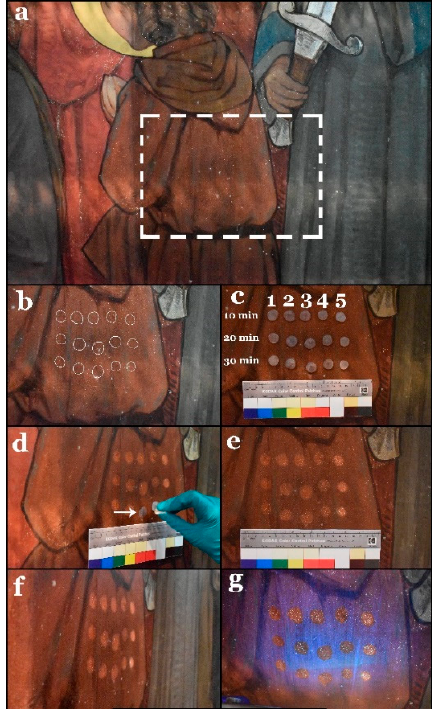
Figure 5. ( a ) General view of the selected area for the first stage tests. ( b ) Selected spots before the treatment indicated by white circles. ( c ) The five hydrogel composites applied to the surface during three different contact times: 10, 20, and 30 min. The numbers 1 to 5 represent the hydrogels loaded with 10% EA, 10% PC, 5%/5% EA/PC, 10% MEK, and 5%/5% MEK/1-PeOH, respectively. ( d ) Treatment of the surface with a dry cotton ball after peeling off the hydrogel pellets. The arrow refers to the swelling of the varnish resulting in a whitish haze. ( e ) View of the selected area after gel cleaning treatments. ( f ) View of the same area under raking light. ( g ) The same view under UV light showing the disappearance of the varnish fluorescence and the severe damage that occurred at the treated spots with the 5%/5% MEK/1-PeOH hydrogel composite (right-most column of test